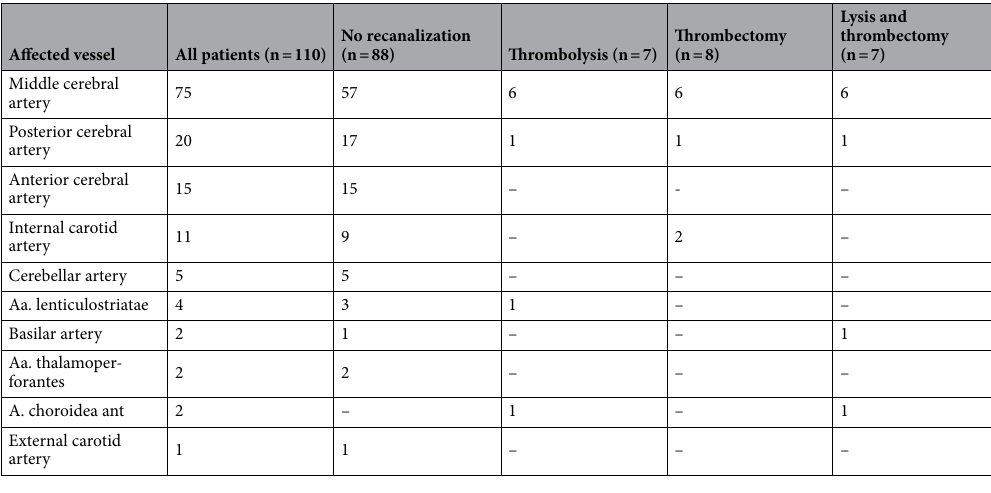
Table 4. Affected vessels. Multiple affected vessel per patients (sum larger than total number). Affected vessels in the RT (n = 22) and non-RT groups (n = 88; data missing from 54